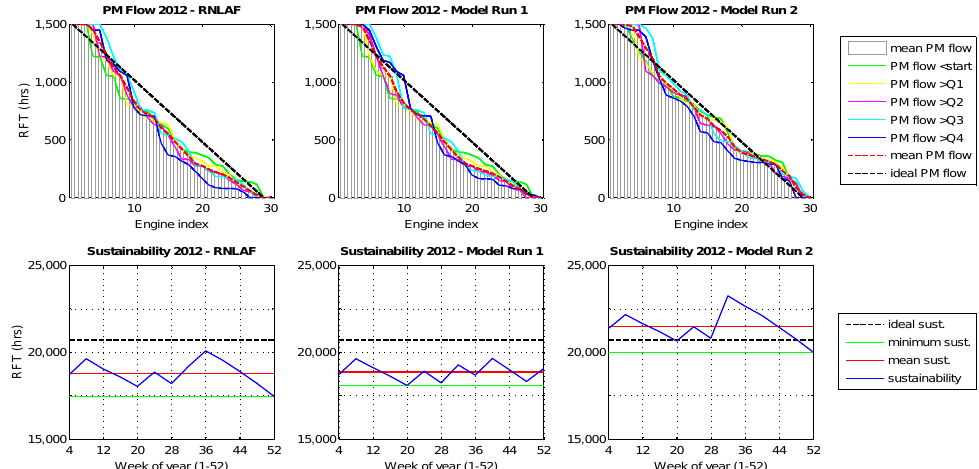
Figure 8. Results of the CMP optimization model with respect to sustainability for the year 2012. Simulated RNLAF results (left) are presented alongside the output of two model runs for the same year (middle and right).